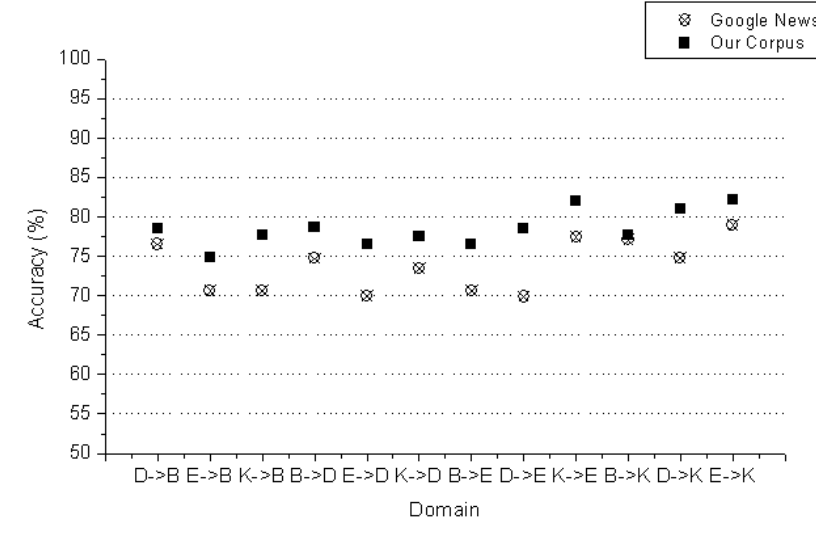
Figure 4. Comparison of word embedding pre-trained on Google News and the proposed corpus.